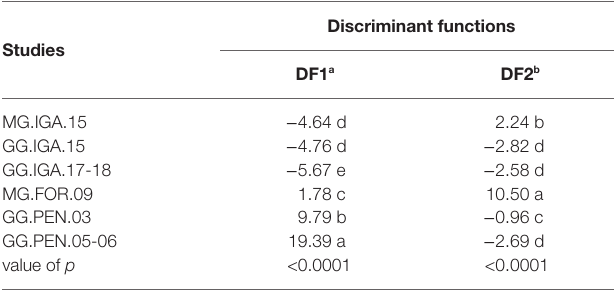
a Discriminant function 1. b Discriminant function